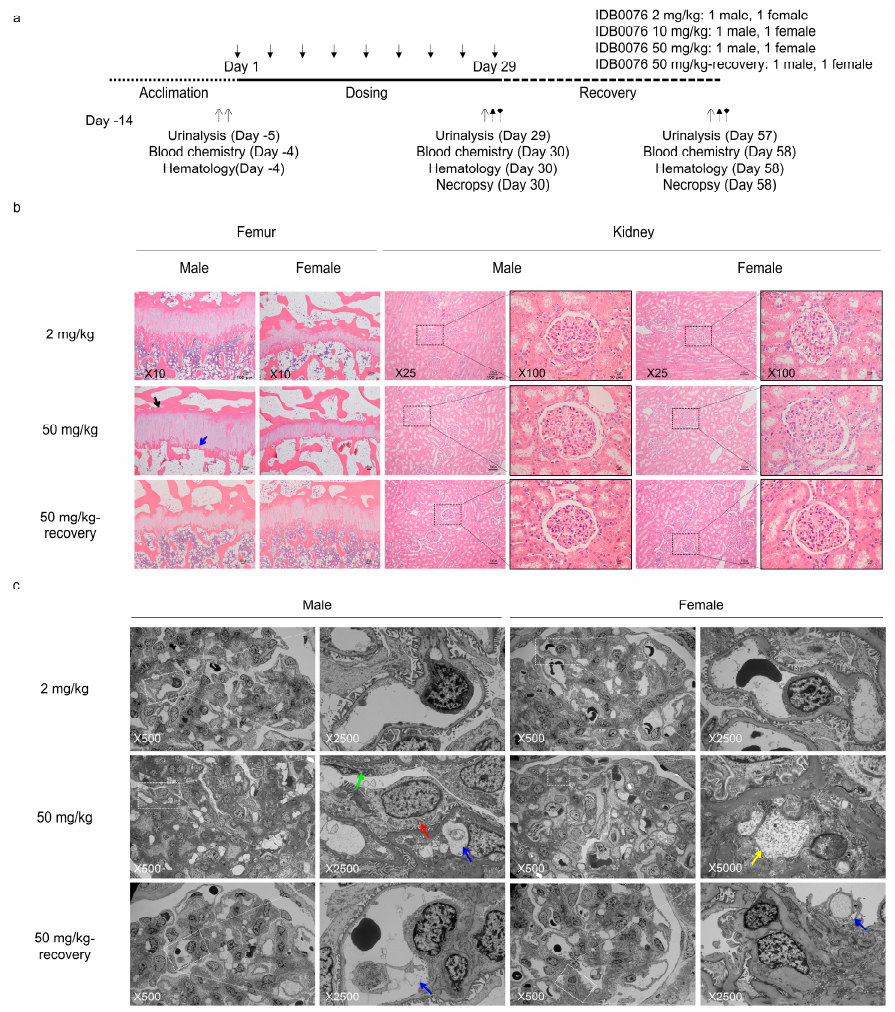
Figure 5. Toxicity of IDB0076 was investigated in cynomolgus monkeys at doses of 2, 10, and 50 mg/kg during 4 weeks. ( a ) Experimental design for the evaluation of IDB0076 toxicity in cynomolgus monkeys. ( b ) Light-microscopic appearance of the femur and kidneys from monkeys treated with IDB0076 was examined at the end of dosing and after the end of the recovery period. Black and blue arrows indicate the thickness of the physis and the primary trabecular bone, respectively (magnification: × 10). The kidney section illustrates a glomerulus at lower ( × 25) and higher magnification ( × 100). ( c ) Electron-microscopic images of glomeruli from monkeys treated with IDB0076 at the end of dosing and after the end of the recovery period. Representative images of a glomerulus are shown at lower ( × 500) and higher magnification ( × 2500). Granular / vesicular material in mesangial cells was detected in females at the 50 mg / kg dose ( × 5000 magnification). Each colored arrow indicates a change of the glomerulus as follows: red, hypertrophy of podocytes; green, shortening of foot processes in the podocytes; blue, retention of vesicles in the capillary; yellow, granular / vesicular material in mesangial cells.